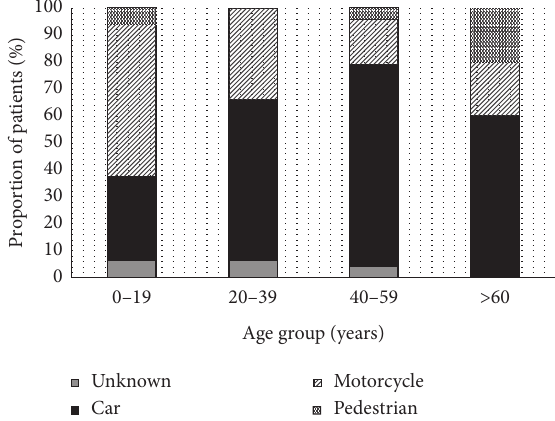
Figure 2: Distribution of vehicle modes involving in the injury by age